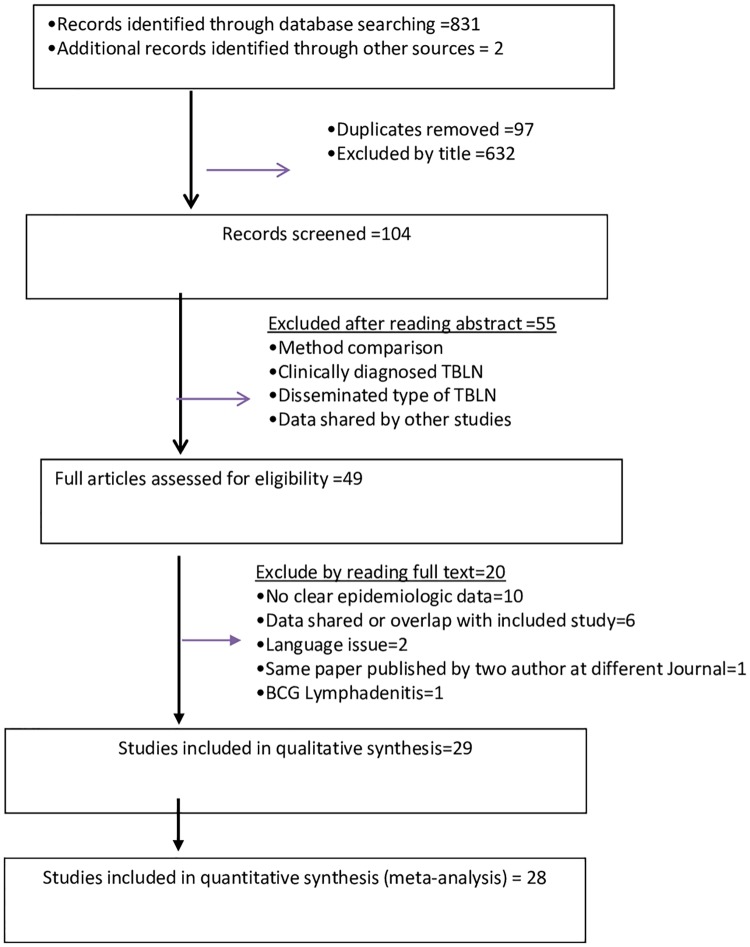
PRISMA flow diagram of literature selection, Africa, 2018.